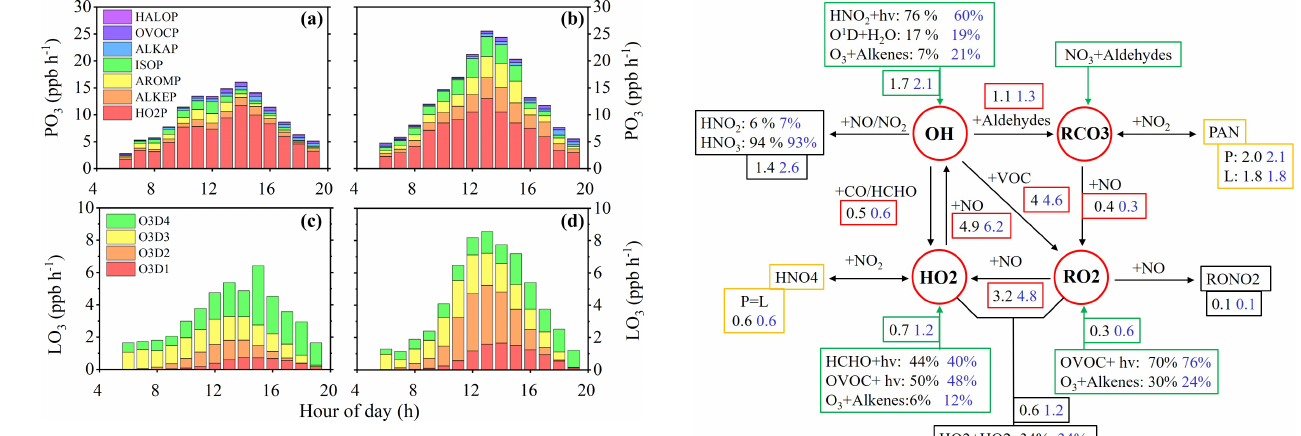
Figure 3. Mean diurnal profile of the instantaneous ozone produc- tion and destruction rate calculated from the MCM-OBM model (instantaneous ozone rate derived from observed VOCs in a and c and from PIC-VOCs in panels b and d ). The upper panels present the speciation of the ozone formation rate. The lower panels present the speciation of the ozone destruction rate. The data range is 1–28 August 2019.